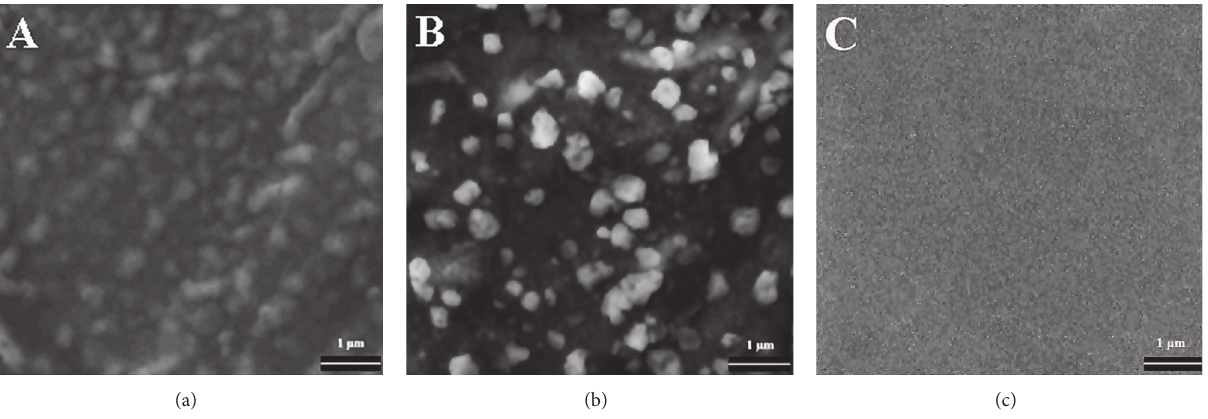
Figure 1: SEM images of Ti-Enamel (a) and Ti-PDMS-Enamel (b) layers and Ti substrate (c).